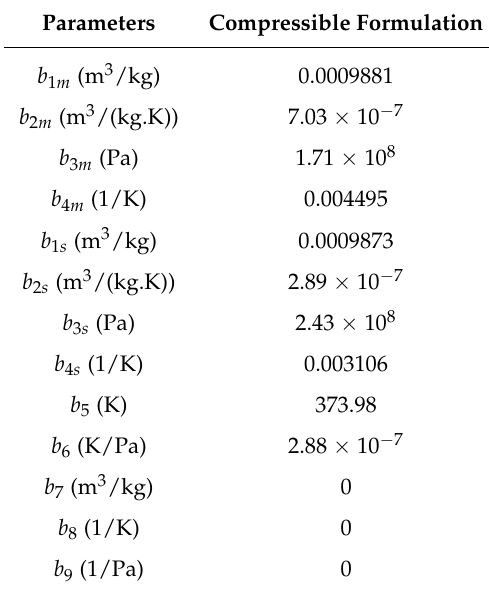
Table 3. Modified Tait model coefficients for the GPPS Styron 678 from Americas Styrenics